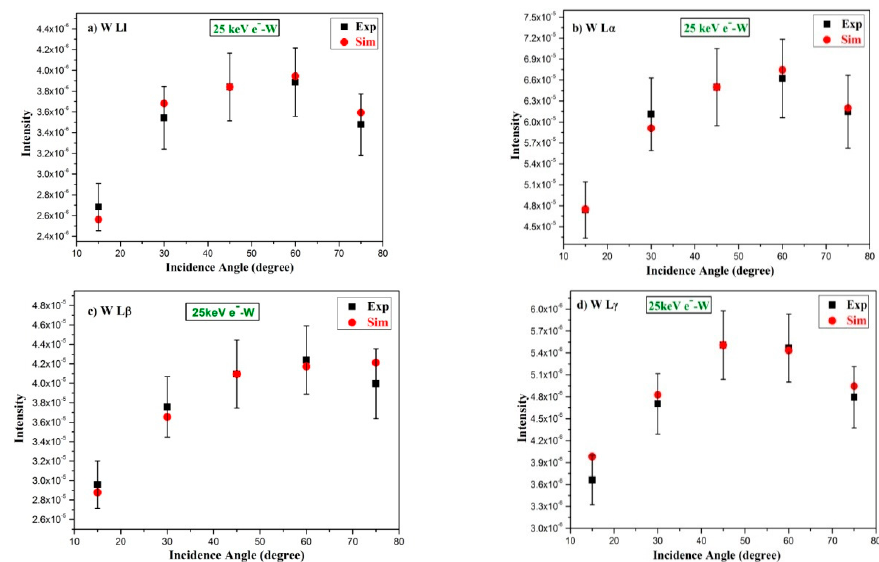
Figure 3. Typical graphs showing variation of the measured relative intensity of ( a ) L l , ( b ) L α , ( c ) L β and ( d ) L γ X-ray lines respectively, produced in collisions of 25 keV electrons with a pure polycrystalline thick W target as a function of incidence angle α . The black squares with error bars represent the measurements and the red circles denote the simulation results. The experimental data have been normalized to theory at α = 45°.